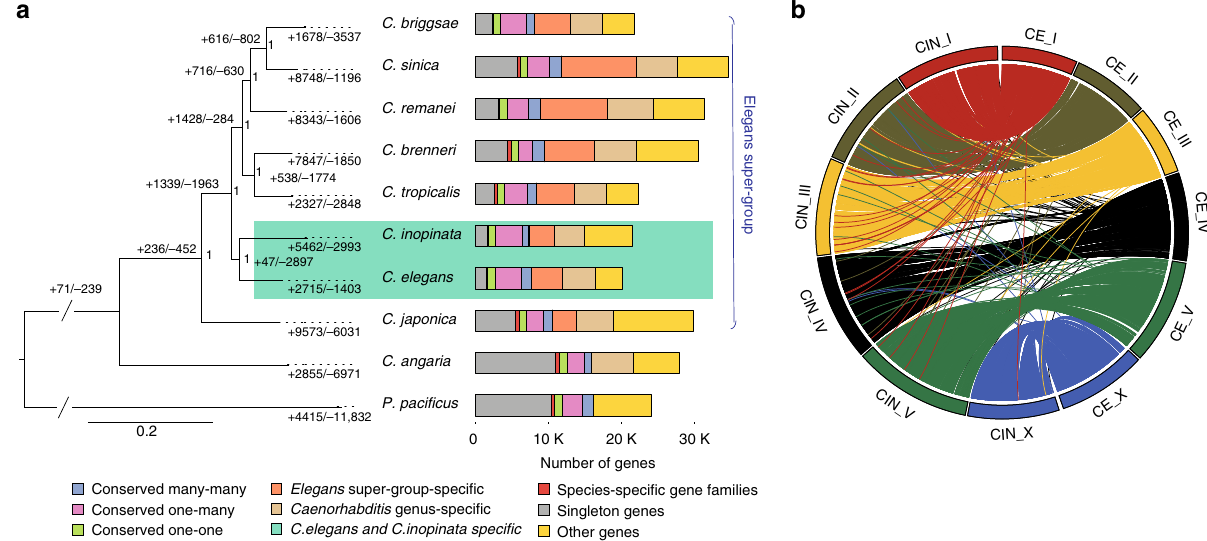
Fig. 2 Genome of C. inopinata compared with C. elegans and other relatives. a Phylogeny and gene family evolution of Caenorhabditis species. Numbers labelled on each branch (or lineage) are the speci fi c gain/loss of that branch (or lineage). Genes are categorised in stack bar, and the length of stack bar is proportional to number of genes. b Single copy orthologues linking C. inopinata and C. elegans